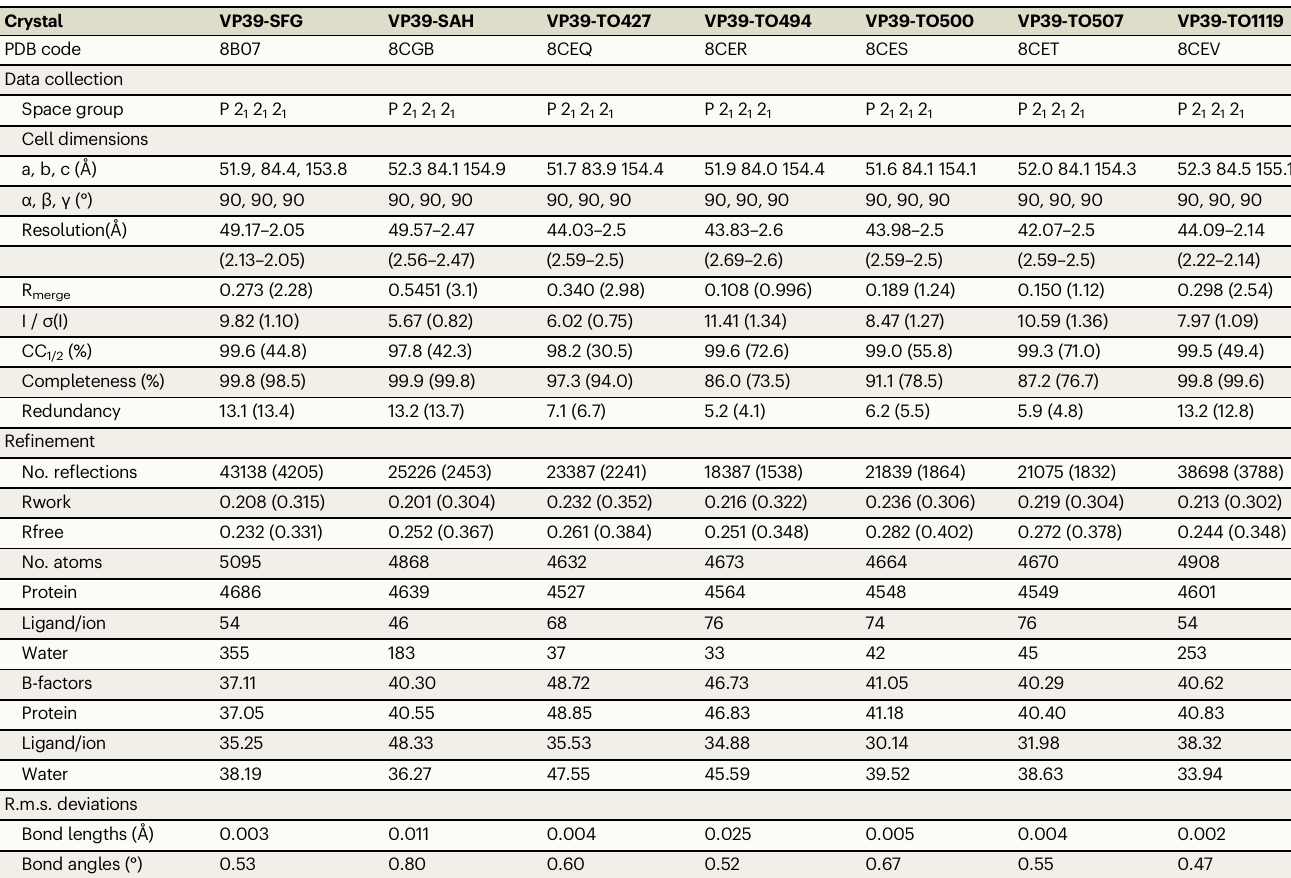
Table 1 | Data collection and re fi nement statistics